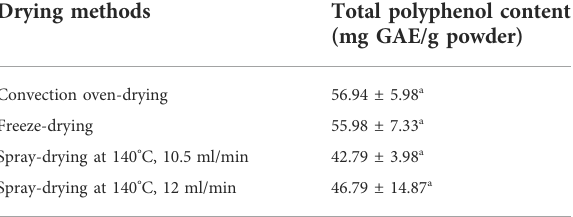
TABLE 3 Total polyphenol content of chamomile extract powder obtained from different drying methods. Drying